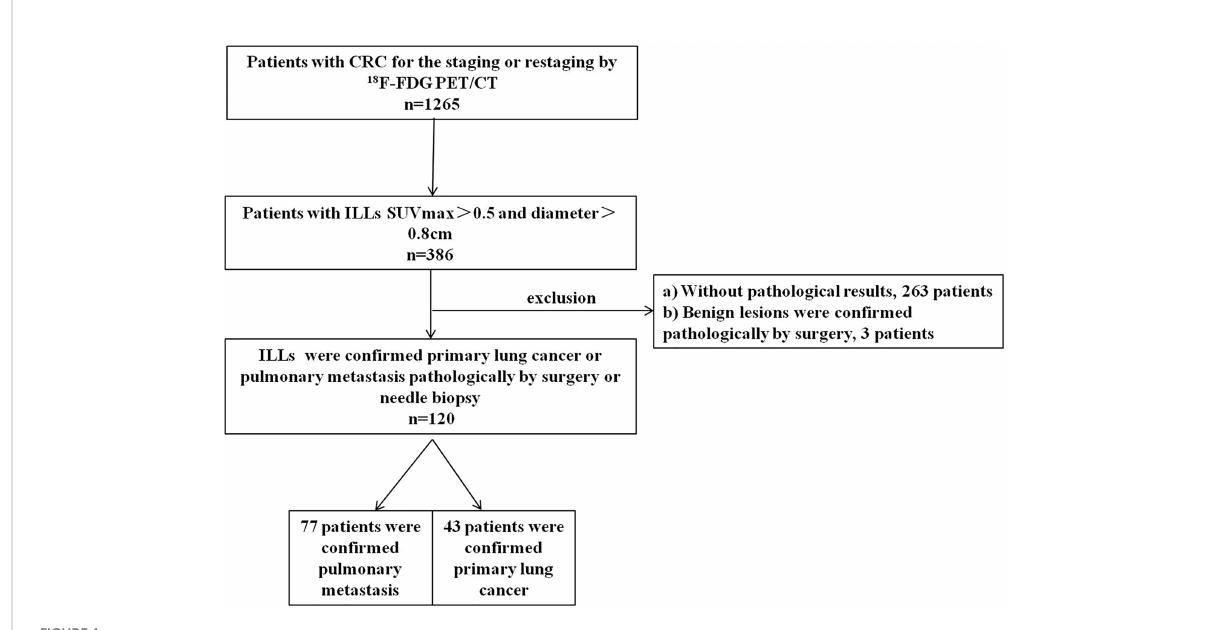
FIGURE 1 Flowchart of patient